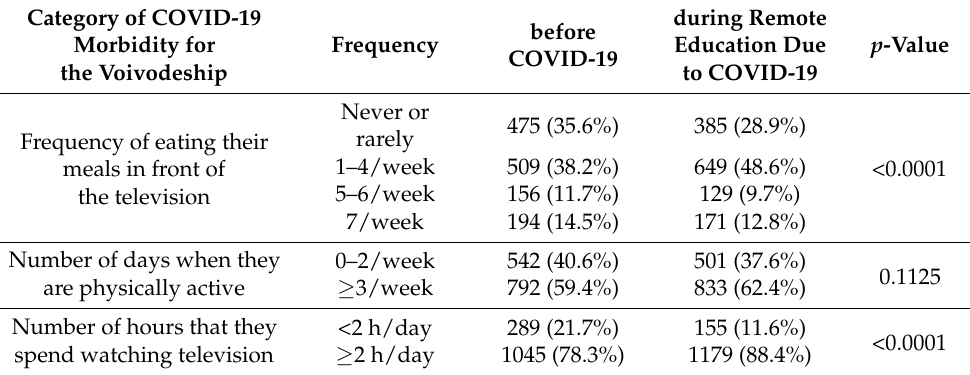
Table 5. Analysis of declared frequency of eating their meals in front of the television, number of days a week when they are physically active and number of hours a day that they usually